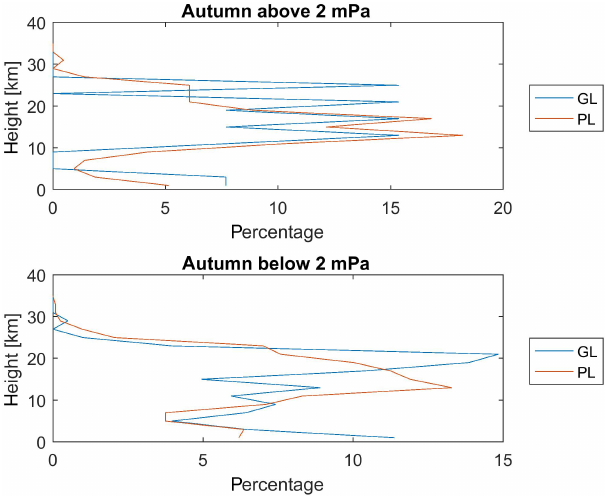
Figure 10. Vertical dependence of lamina occurrence in